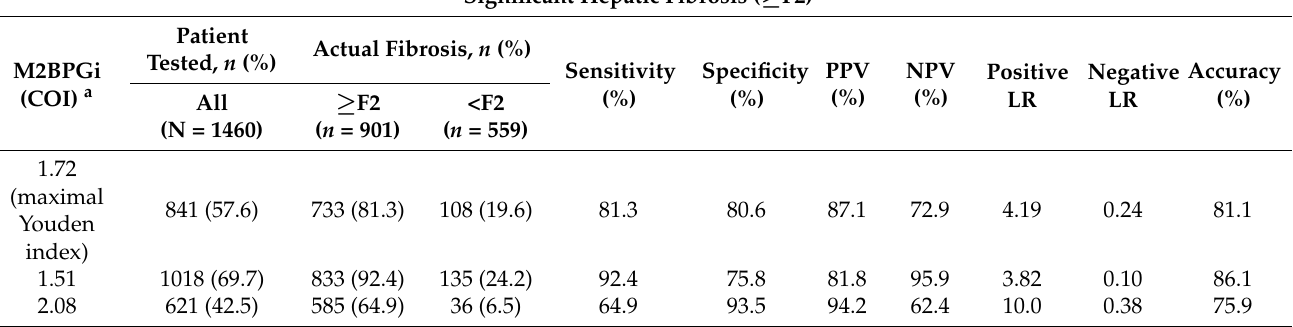
Table 3. Selective cutoff values of Mac-2 binding protein glycosylation isomer (M2BPGi) for prediction of the severity of hepatic fibrosis.